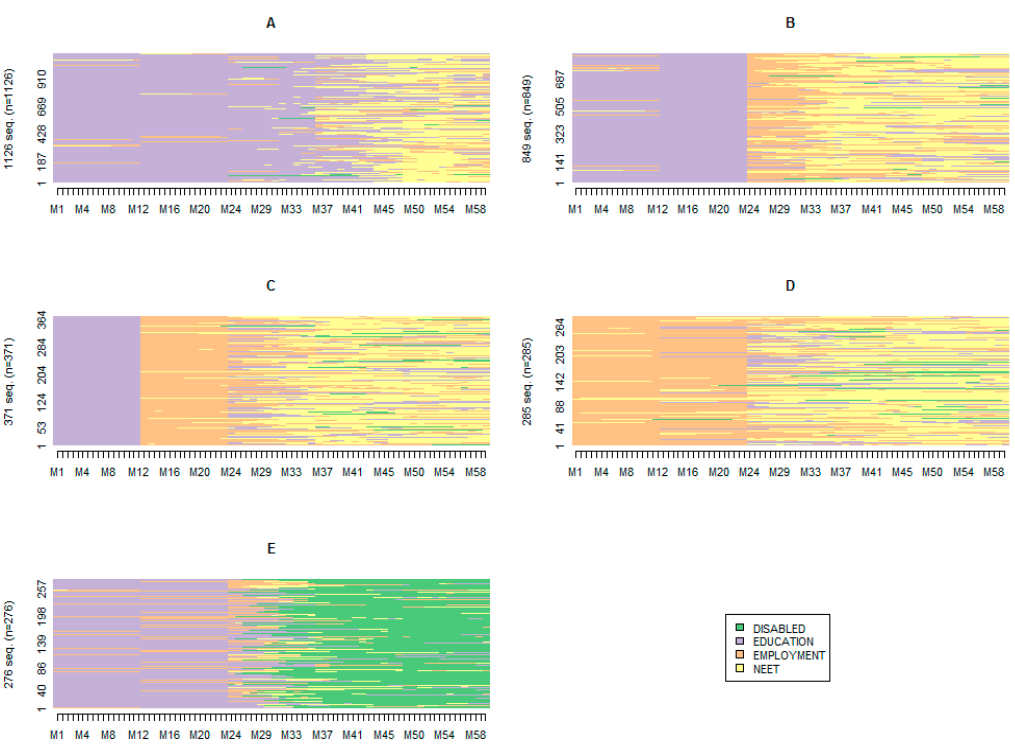
Figure 1 . Sequence index plots by cluster; young adults aged 16–20 with a minimum of six months not in employment or education. Note: purple = education; orange = employment; yellow = NEET; green = disability pension.